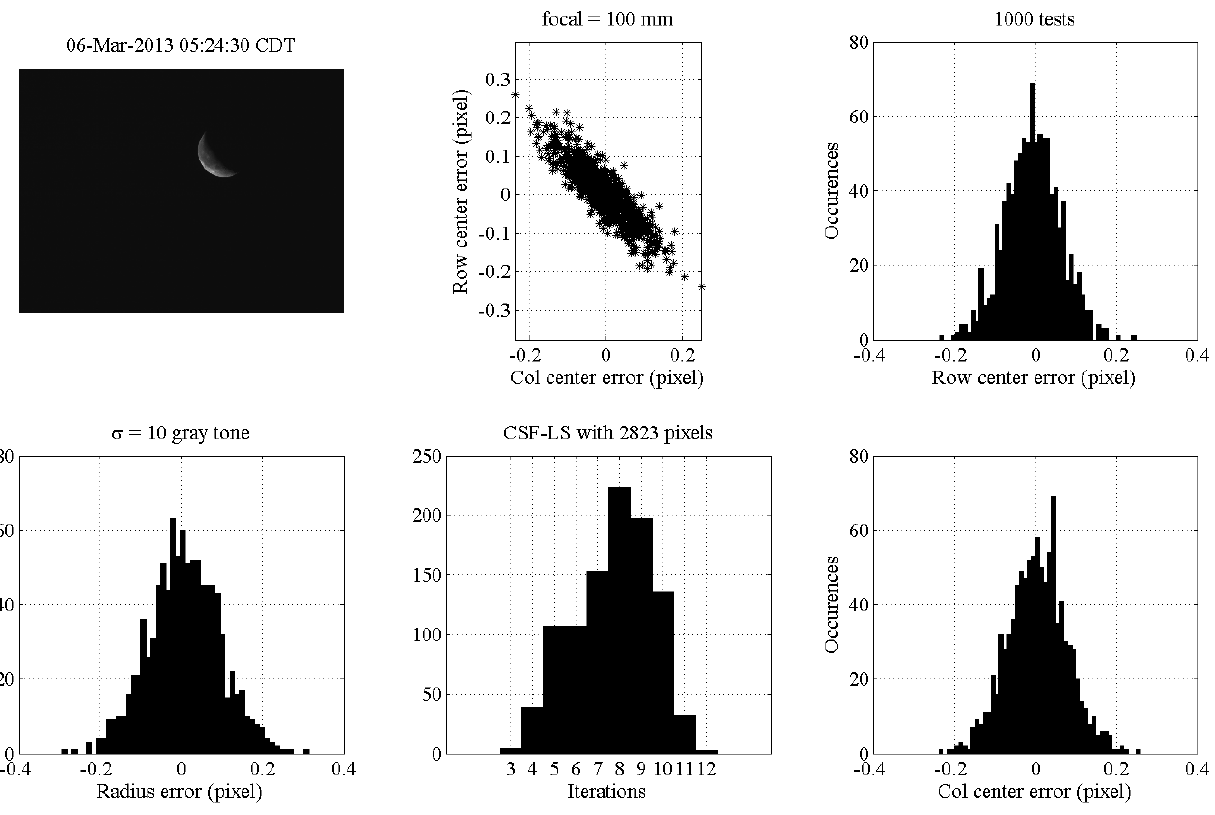
Figure 19. Image processing error results: partial illumination